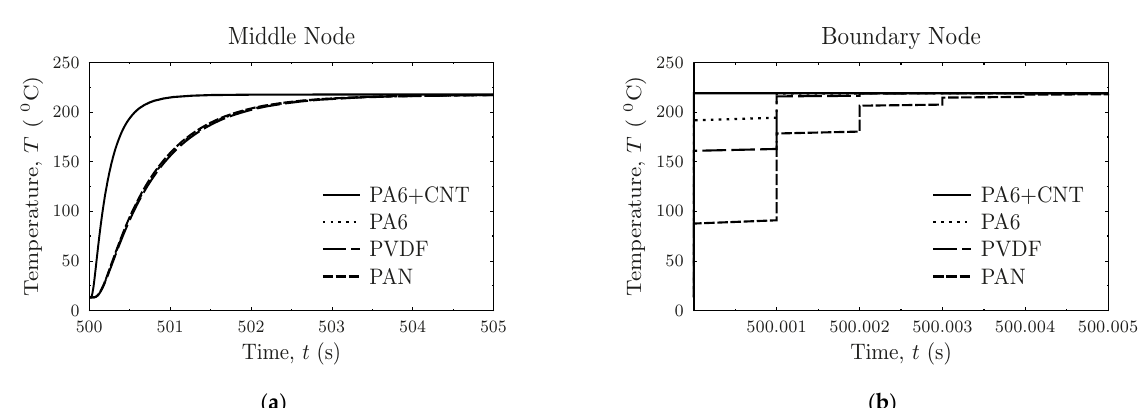
Figure 8. ( a ) Transient heat transfer at middle node 30,287. ( b ) Transient transfer at boundary node 34,668.